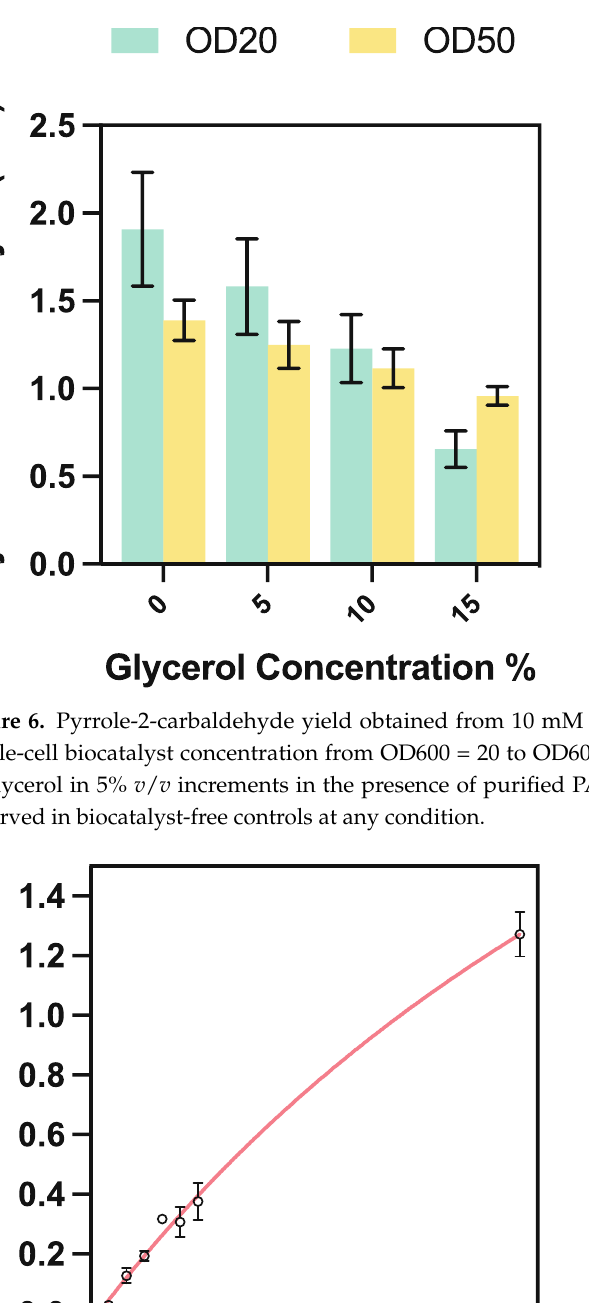
Figure 6. Pyrrole-2-carbaldehyde yield obtained from 10 mM pyrrole by increasing final CARse whole-cell biocatalyst concentration from OD600 = 20 to OD600 = 50, and from supplementation of glycerol in 5% v / v increments in the presence of purified PA0254. No product formation was ob-